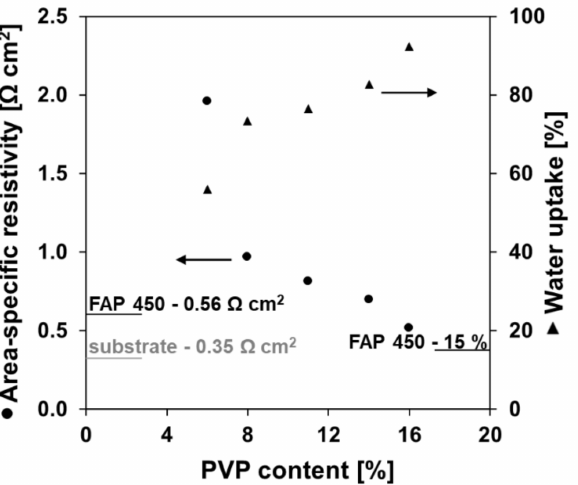
Figure 3. Area-specific resistance (1 M HCl, scan rate 10 mA.s − 1 ) and anion exchange coating water uptake of the fabricated membranes. Values for a commercial reference (FAP 450) and the bare substate are indicated with lines in the plot.